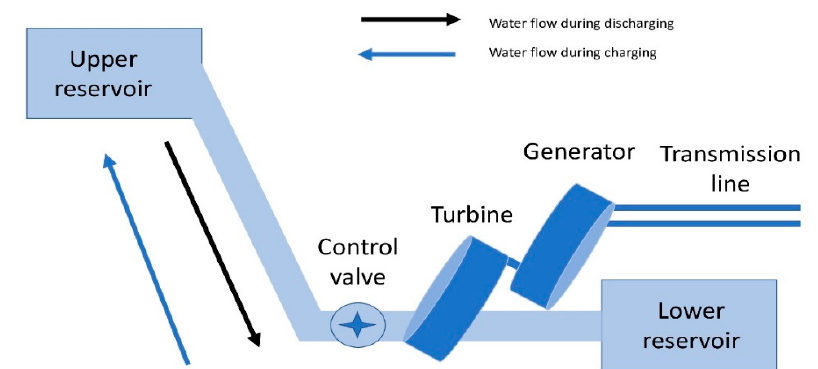
Figure 6. Representation of a pumped hydro energy storage system .